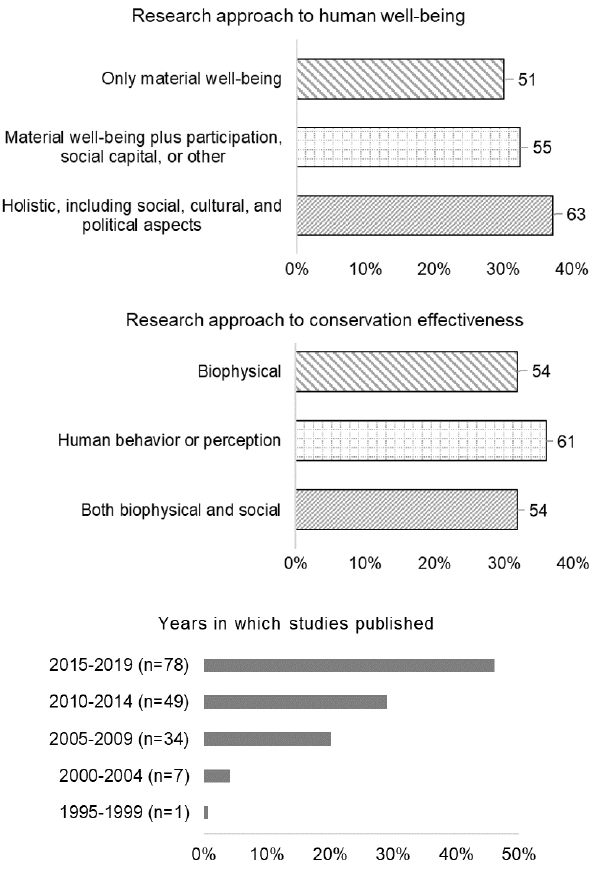
Fig. 1 . Characteristics of the 169 studies included in the review: (a) research approach to human well-being; (b) research approach to conservation effectiveness; and (c) years in which the studies were published.